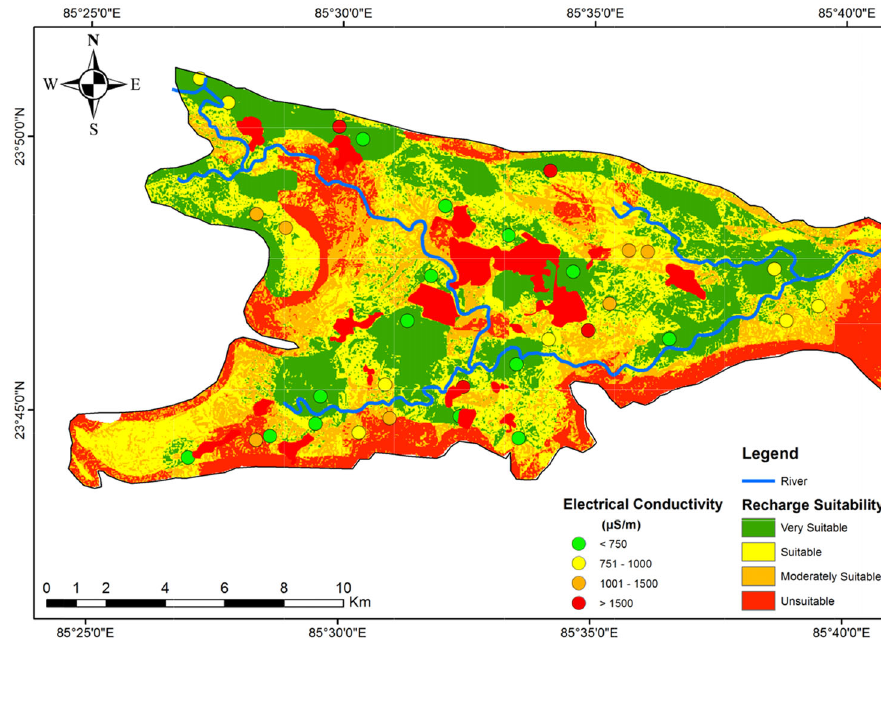
Fig. 10 Electrical conductivity map for validation of recharge suitability of the West Bokaro coalfield